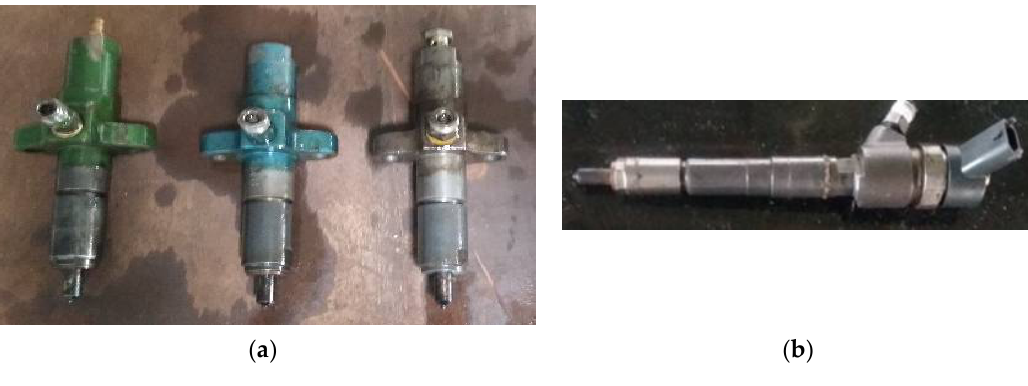
Figure 3. ( a ) Conventional injector [44], ( b ) CRDI injector [43].